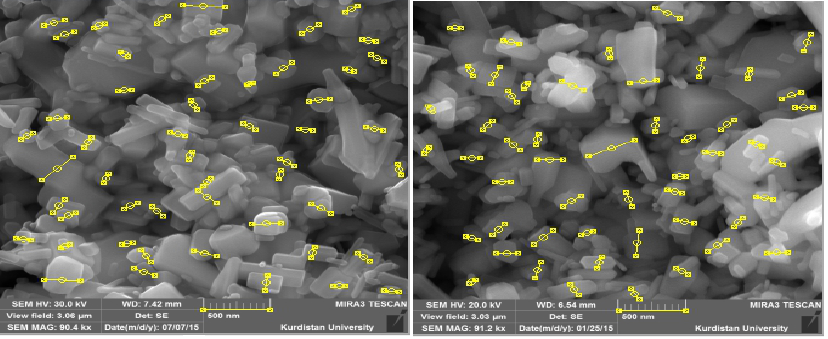
Fig. 1. SEM images of nanoparticles: a) 1.0% molybdenum doped ZnO and b) undoped ZnO